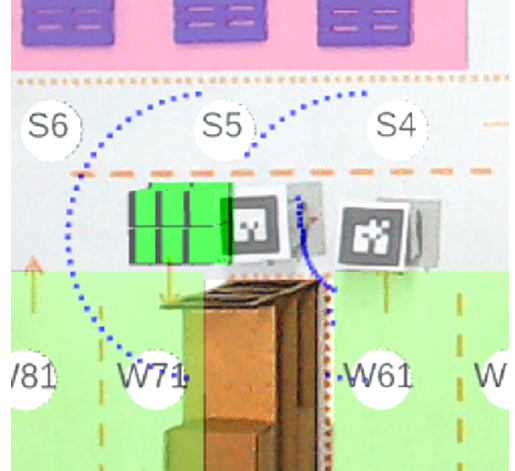
Figure 13. Example of obstacle detection with virtual